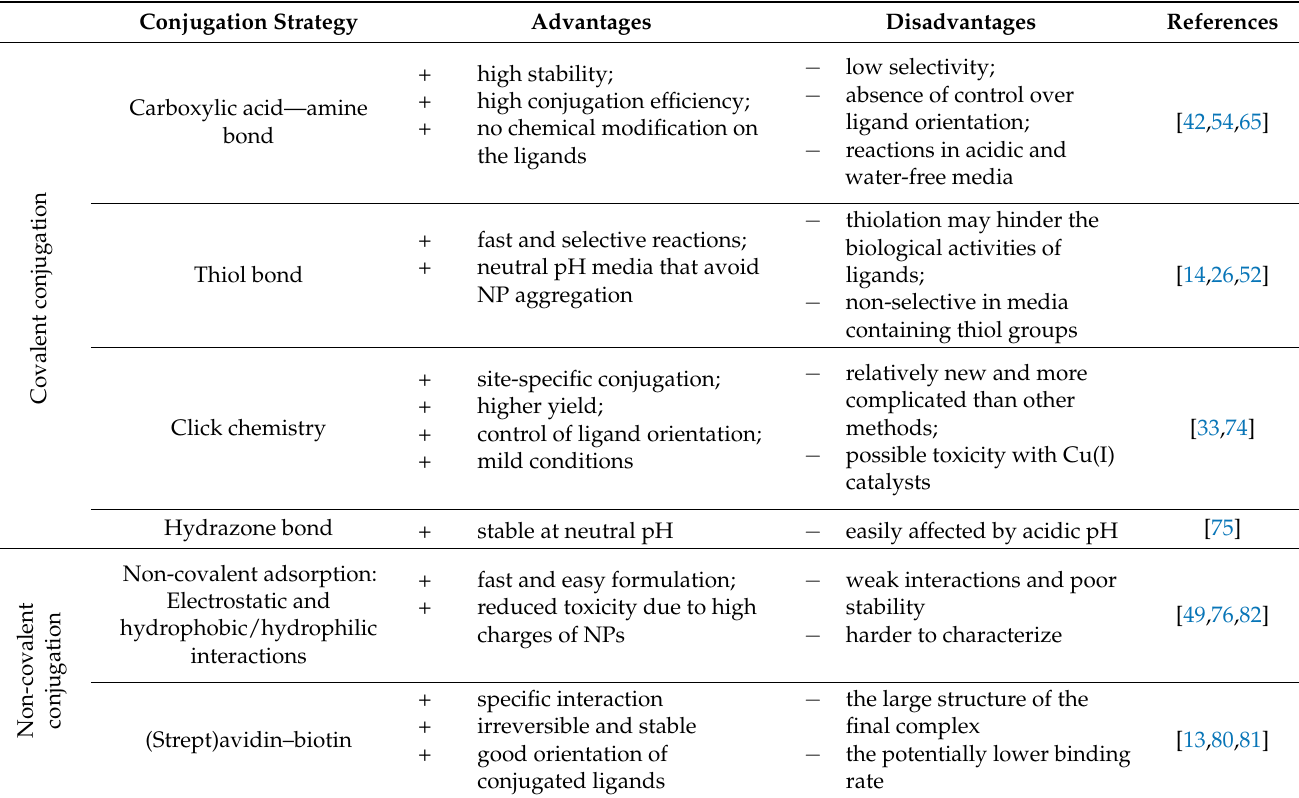
Table 2. Covalent and non-covalent strategies for the functionalization of